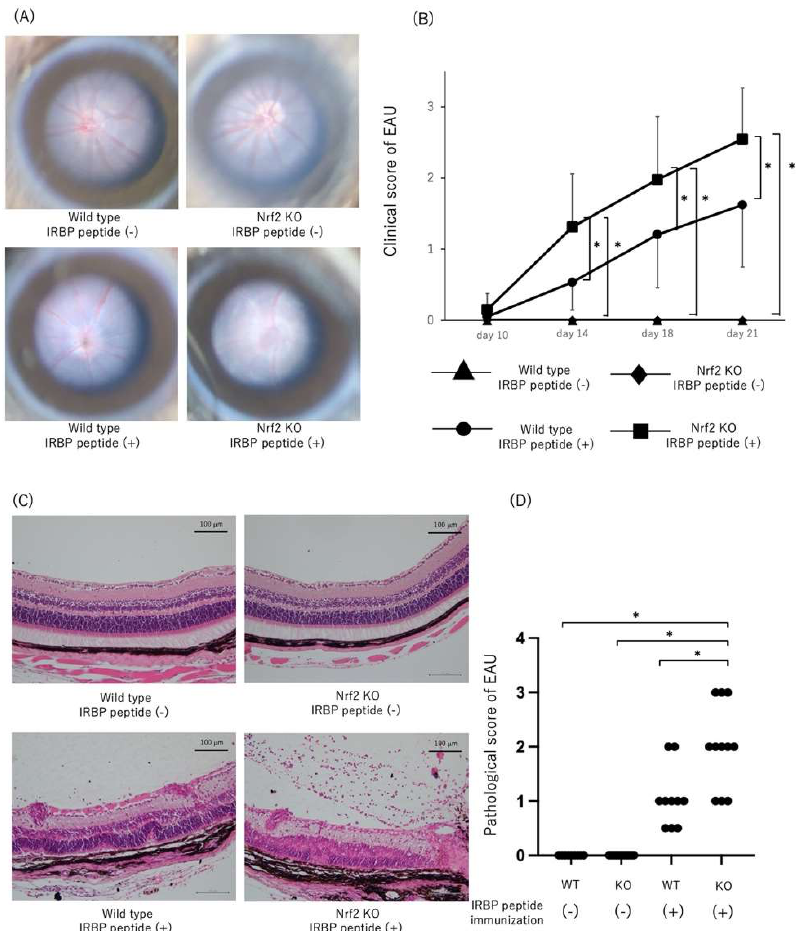
Figure 1. Genetic ablation of Nrf2 exacerbates EAU. Wild type (WT) and Nrf2 knockout (Nrf2 KO) mice were immunized with IRBP peptide, and the clinical score and pathological score were evaluated. ( A ): Fundus images of non-immunized WT mice and Nrf2 KO mice as control and WT mice immunized with IRBP peptide and Nrf2 KO mice immunized with IRBP peptide. Non-immunized WT mice ( n = 11 mice) and Nrf2 KO mice ( n = 11 mice) showed no inflammatory changes. WT mice immunized with IRBP peptide (on day 18 after immunization) revealed retinal vasculitis (clinical score: 2) and Nrf2 KO mice immunized with IRBP peptide (on day 18 after immunization) showed retinal vasculitis and retinal exudates (clinical score: 3). ( B ): The changes of clinical score of EAU in non-immunized WT mice ( n = 11 mice), non-immunized Nrf2 KO mice ( n = 11 mice), immunized WT mice ( n = 22 mice), and immunized Nrf2 KO mice ( n = 22 mice). Clinical score was evaluated on days 10, 14, 18, and 21 after immunization. The mean ± standard deviation for each group is shown. Asterisk indicates p < 0.05 versus Nrf2 KO mice immunized with IRBP peptide. Statistical analysis was performed according to ANOVA followed by Bonferroni test . ( C ): HE sections of non-immun- ized WT mice and Nrf2 KO mice and WT mice immunized with IRBP peptide and Nrf2 KO mice immunized with IRBP peptide. Non-immunized WT mice ( n = 9 mice) and Nrf2 KO mice ( n = 11 mice) showed no inflammatory cells in vitreous and retina. Nrf2 KO mice immunized with IRBP peptide revealed enhanced inflammation in the posterior segment with severe vitreous infiltration and destruction of outer retinal layer compared to those of WT mice immunized with IRBP peptide. ( D ): Histopathological score of EAU in non-immunized WT mice ( n = 9 mice), non-immunized Nrf2 KO mice ( n = 11 mice), immunized WT mice ( n = 10 mice), and immunized Nrf2 KO mice ( n = 11 mice) on day 21. Either eye per mouse was used for histopathological analysis. The mean ± standard deviation for each group is shown. Asterisk indicates p < 0.05 versus Nrf2 KO mice immunized with IRBP peptide. Statistical analysis was performed according to ANOVA followed by Bonferroni test . Scale bar: 100 μm.